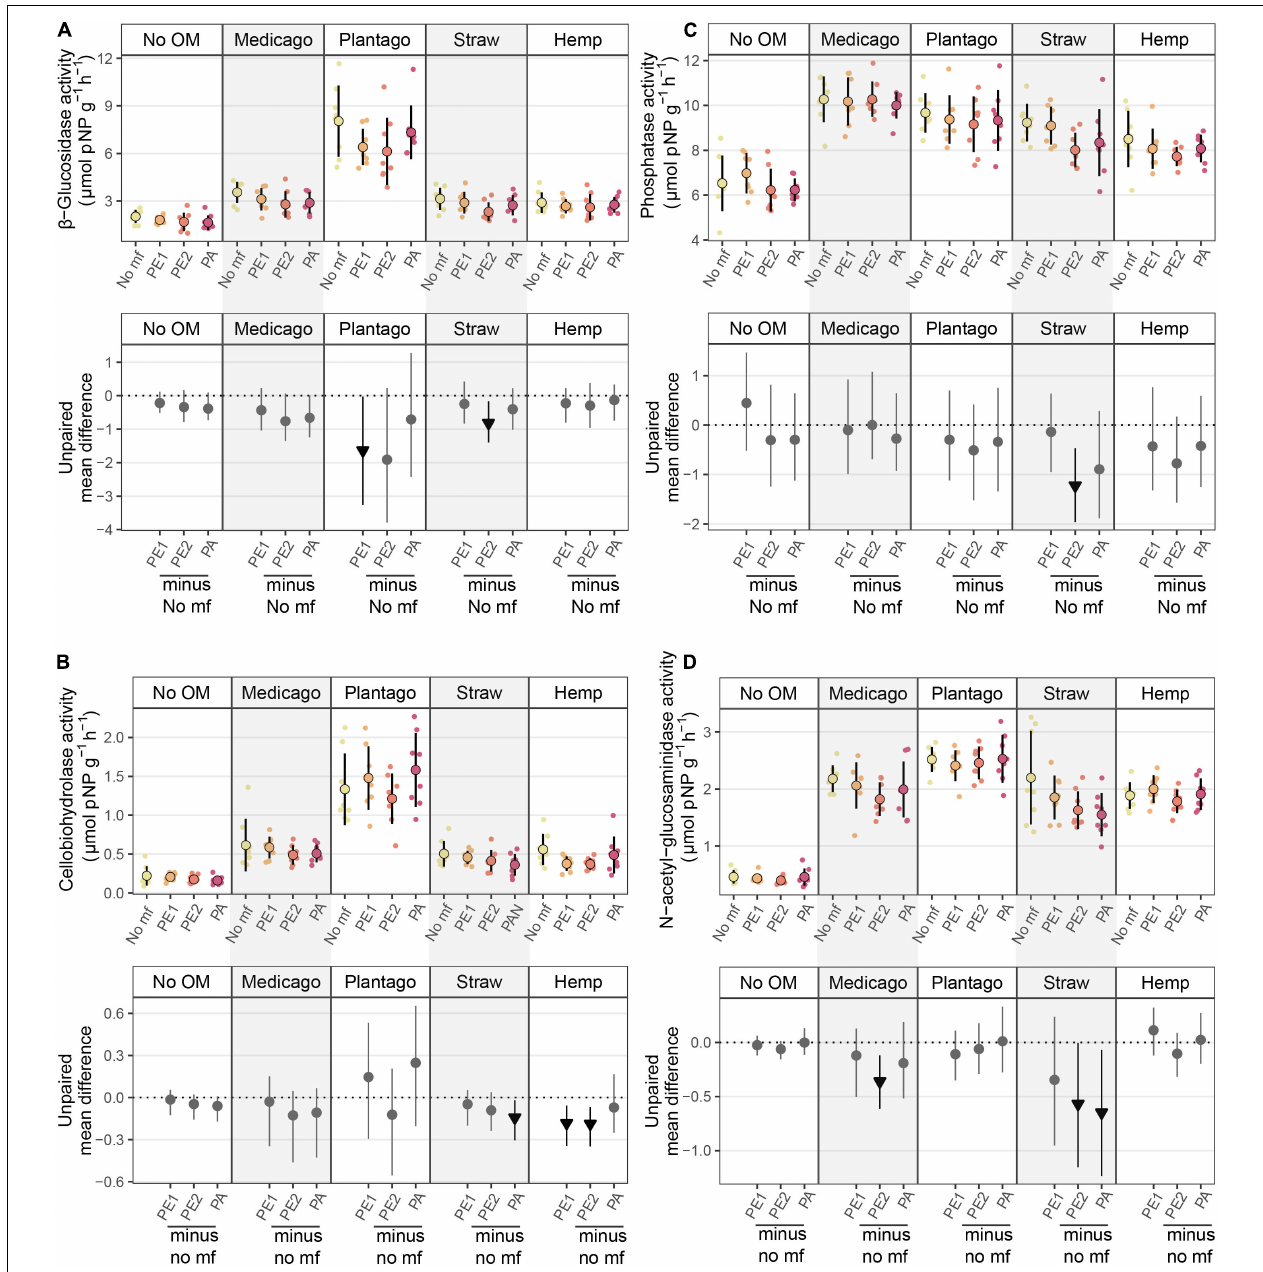
FIGURE 3 | Effects of microplastic fibers on β -Glucosidase activity (A) , cellobiohydrolase activity (B) , phosphatase activity (C) , and N-acetyl-glucosaminidase activity (D) in the presence of different types of organic matter. The upper panel shows the raw data of enzyme activity, data distributions are aligned with corresponding mean and standard deviation ( n = 8 for each treatment). The lower panel shows the unpaired mean differences of the microplastic fiber addition and control with different types of organic matter addition. Circles and triangles represent the effect size mean (unpaired mean; effect magnitude) and the vertical lines the corresponding confidence intervals (effect precision). Negative (arrow head down) effect sizes and corresponding CIs of treatment compared to control are depicted in black while neutral effects (circle) are shown in gray; neutral effects occur when the CIs overlap the dashed zero line (line of no effect). “No OM” represents no organic matter addition, “No mf” represents no microplastic fiber